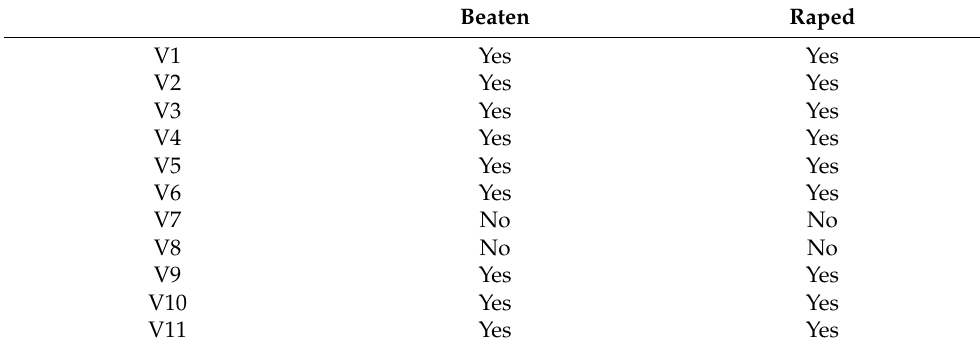
Table 5. Violence against